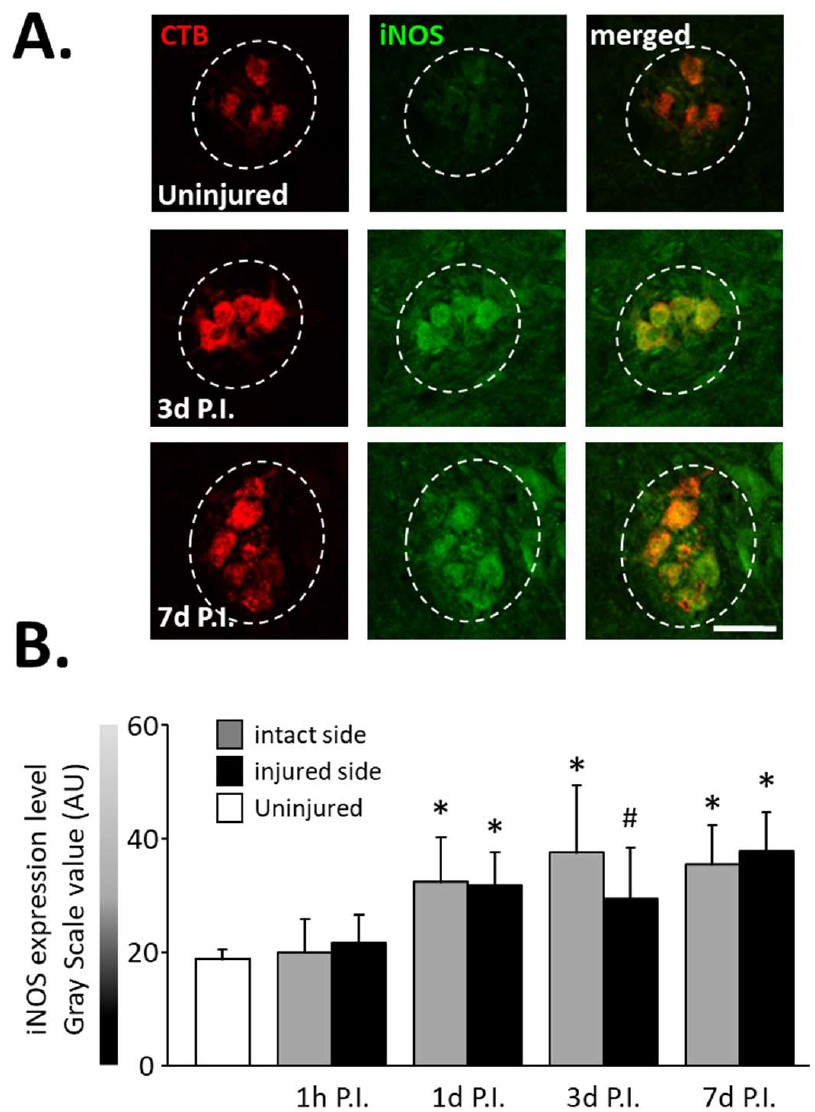
Figure 3. iNOS expression in phrenic motoneurons following C2 hemi-section. ( A ) Representative images showing expression of iNOS in phrenic motoneurons labeled with CTB in uninjured animals and in denervated phrenic motoneurons in C2 hemisected rats, 3 and 7 days post-injury (P.I.). ( B ) Quantification of iNOS in phrenic motoneurons for uninjured animals, and intact and injured sides of C2 hemisected animals 1 h, 1 d, 3 d, and 7 d following injury. # 3 d P.I. injured side, compared with uninjured group, p < 0.05. * Compared to uninjured group and 1 h P.I. corresponding side, p < 0.05.